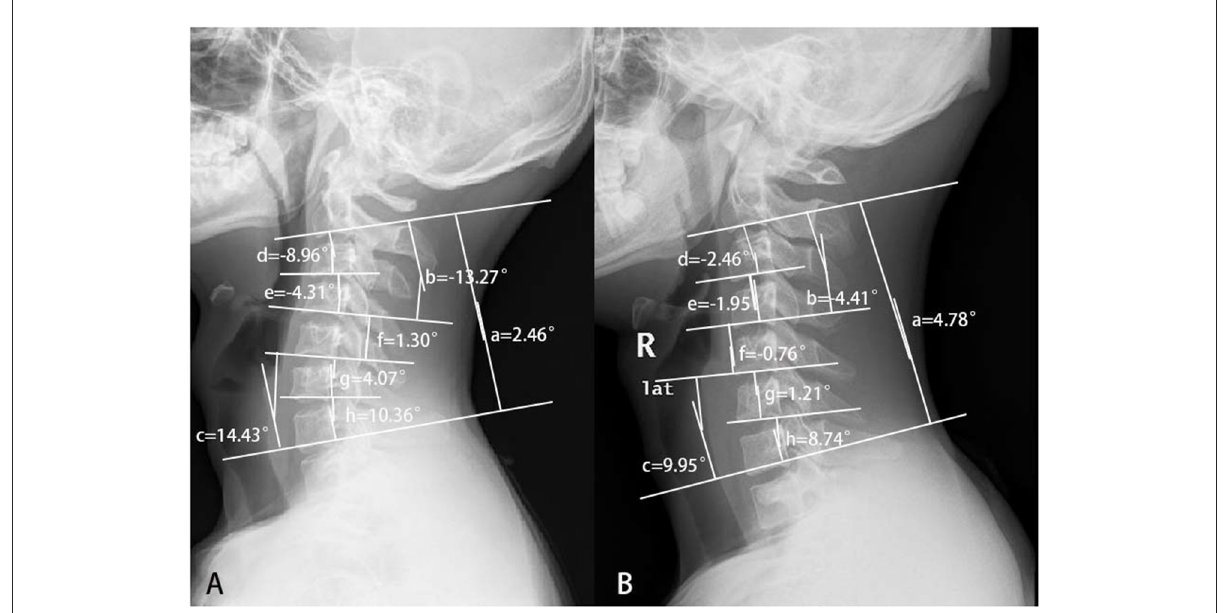
FIGURE4 The different cervical curvatures between patients with proximal and simple distal Hirayama disease. (A) Hirayama disease with proximal involvement: the upper half of the cervical spine turned kyphotic, while the lower half kept lordotic. So, the whole cervical spine looked like a reverse S-shape. (B) Distal HD: the cervical spine turned straight. (a) C2-7 Cobb; (b) C2-4 Cobb; (c) C5-7 Cobb; (d) C2-3 Cobb; (e) C3-4 Cobb; (f) C4-5 Cobb; (g) C5-6 Cobb; and (h) C6-7 Cobb.